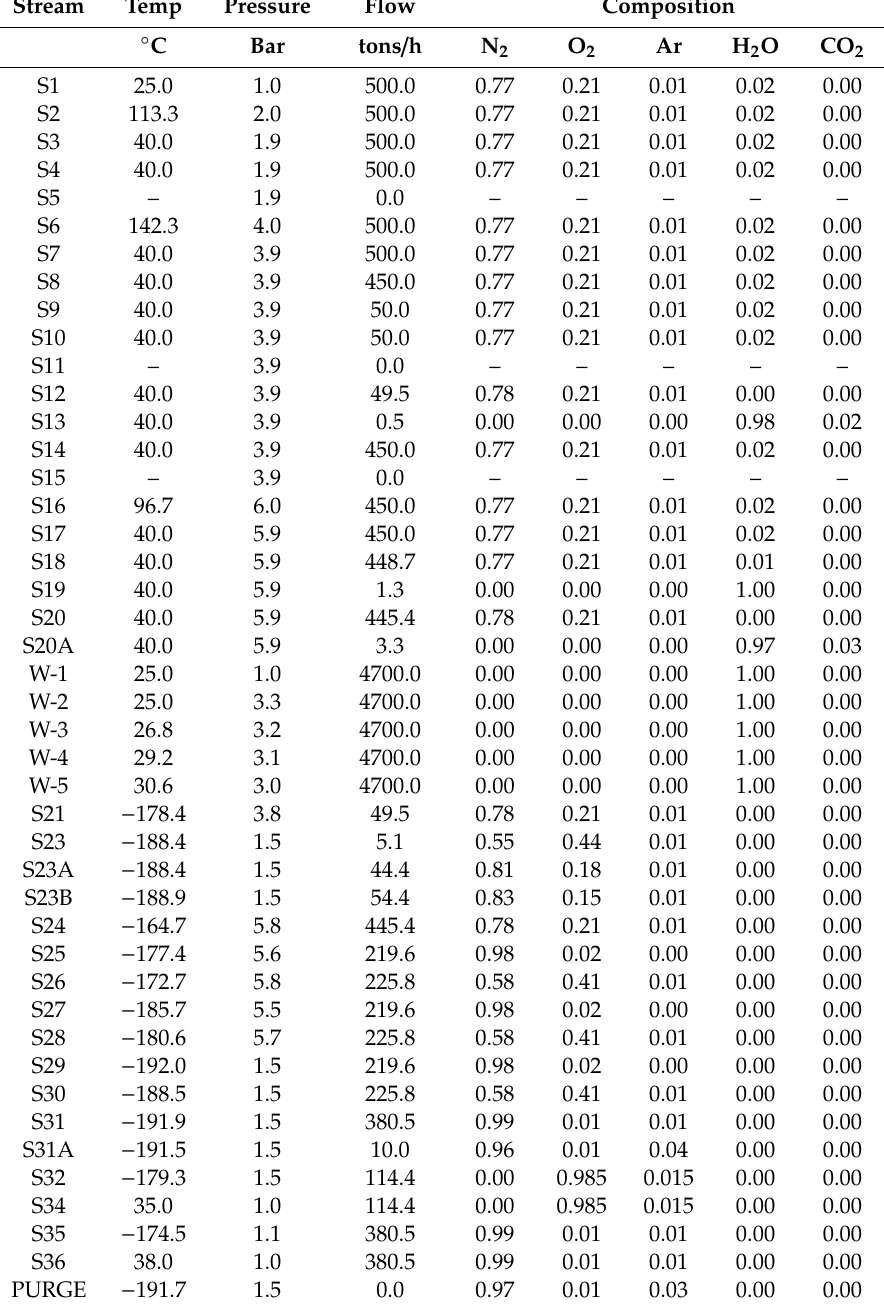
Table 4. Steady-state simulation results for the ASU configuration C4.